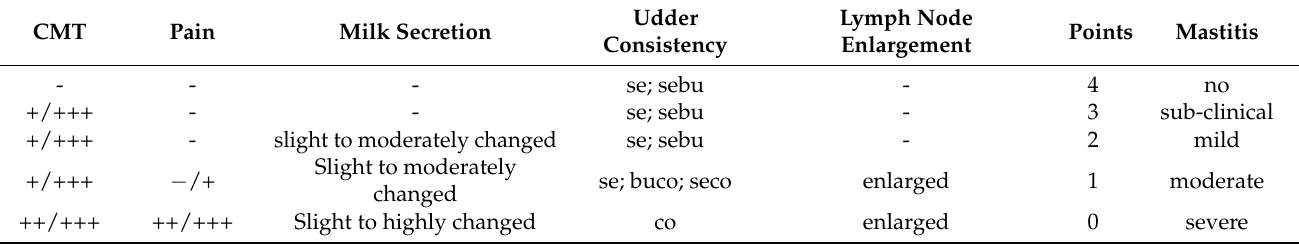
Table 5. Assessment key for udder